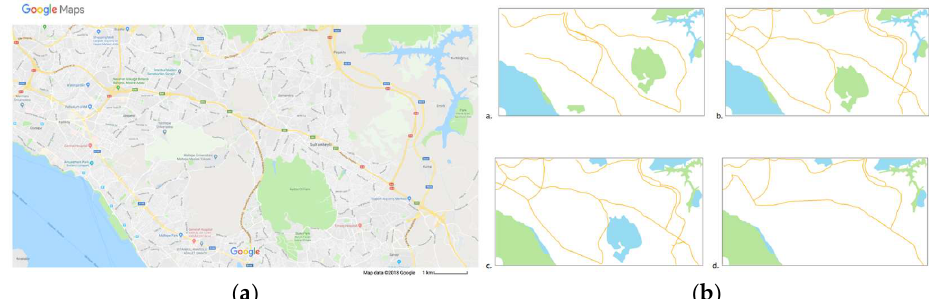
Figure 2. ( a ). Example stimulus (( a ) larger version of the map(s) can be seen in Appendix B); ( b ). correct skeleton map in multiple-choice graphical answer screen